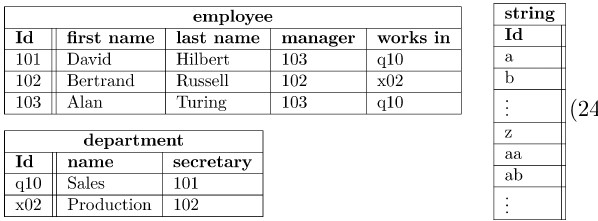
schema. Each box represents a table, each arrow out of a box represents a column of that table. Here is an example state of that